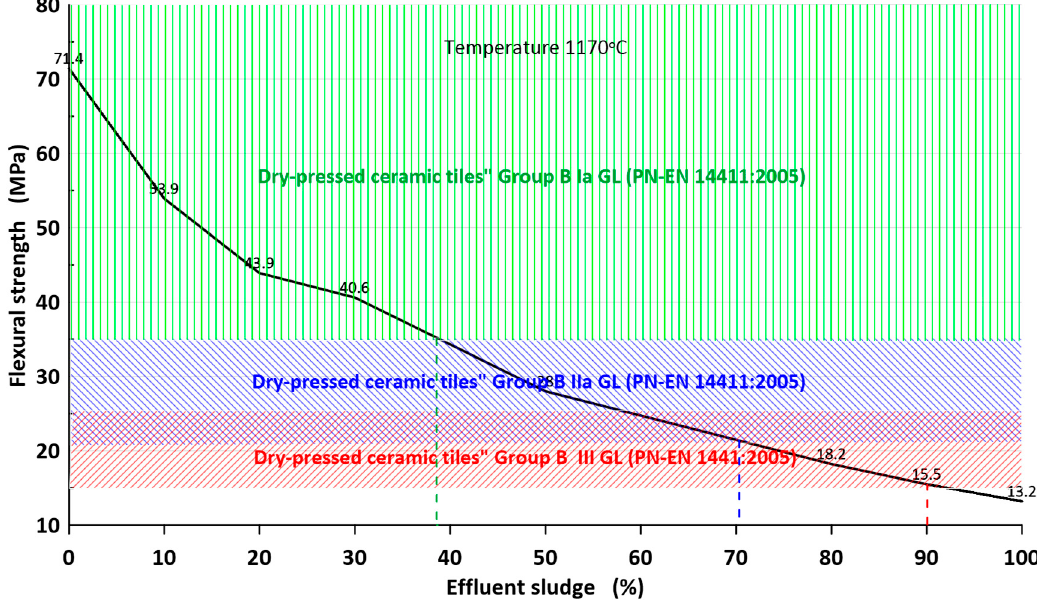
Figure 9. The influence of the sludge content in the tiles mass on the mechanical bending strength in terms of the requirements for wall and floor ceramic tiles.